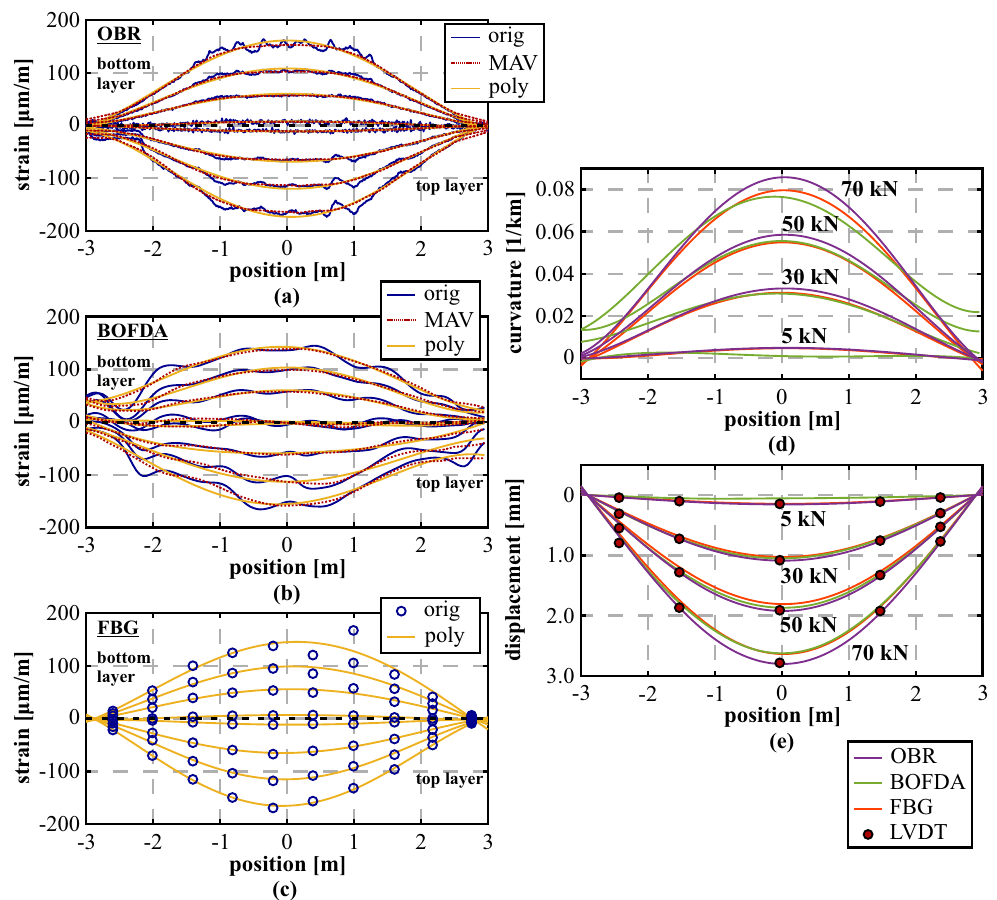
Figure 13. Analysis of different sensing units: ( a ) Distributed strains (OBR). ( b ) Distributed strains (BOFDA). ( c ) Quasi-distributed strains (FBG) ( d ) Derived curvature profiles. ( d ) Displacement curves calculated from DFOS strains and measured by LVDT. ( e ) The distributed displacement curves along the beam.